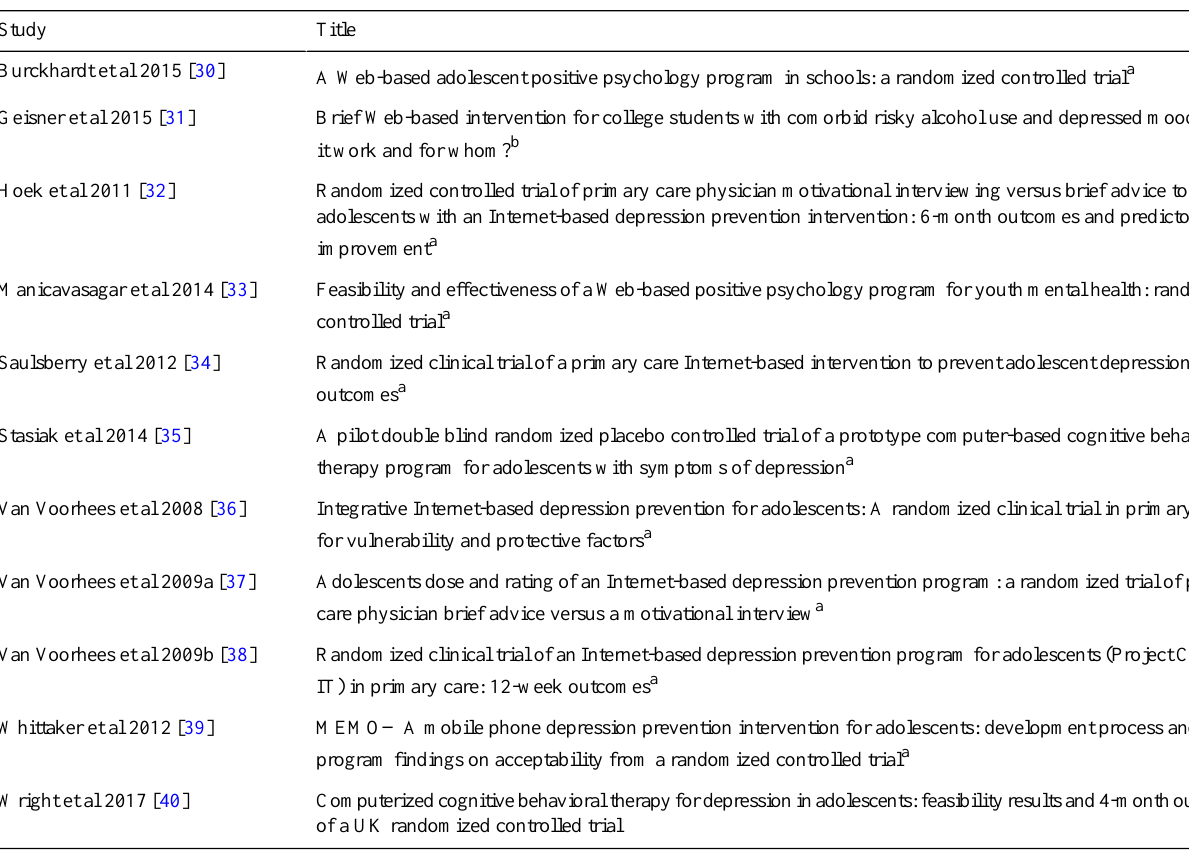
Table 1. Excluded studies from the meta-analysis and reason for being excluded. TitleStudy A Web-based adolescent positive psychology program in schools: a randomized controlled trial a Burckhardt et al 2015 [30] Brief Web-based intervention for college students with comorbid risky alcohol use and depressed mood: